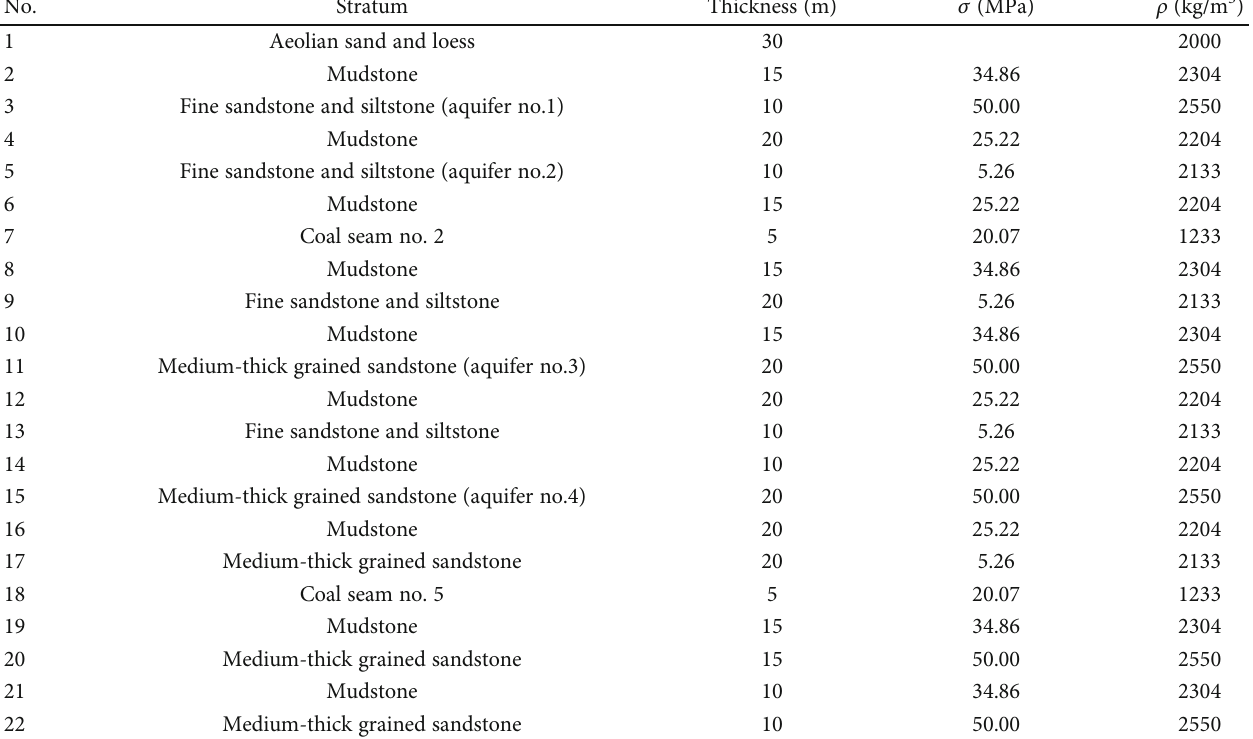
Table 2: Generalized stratigraphic